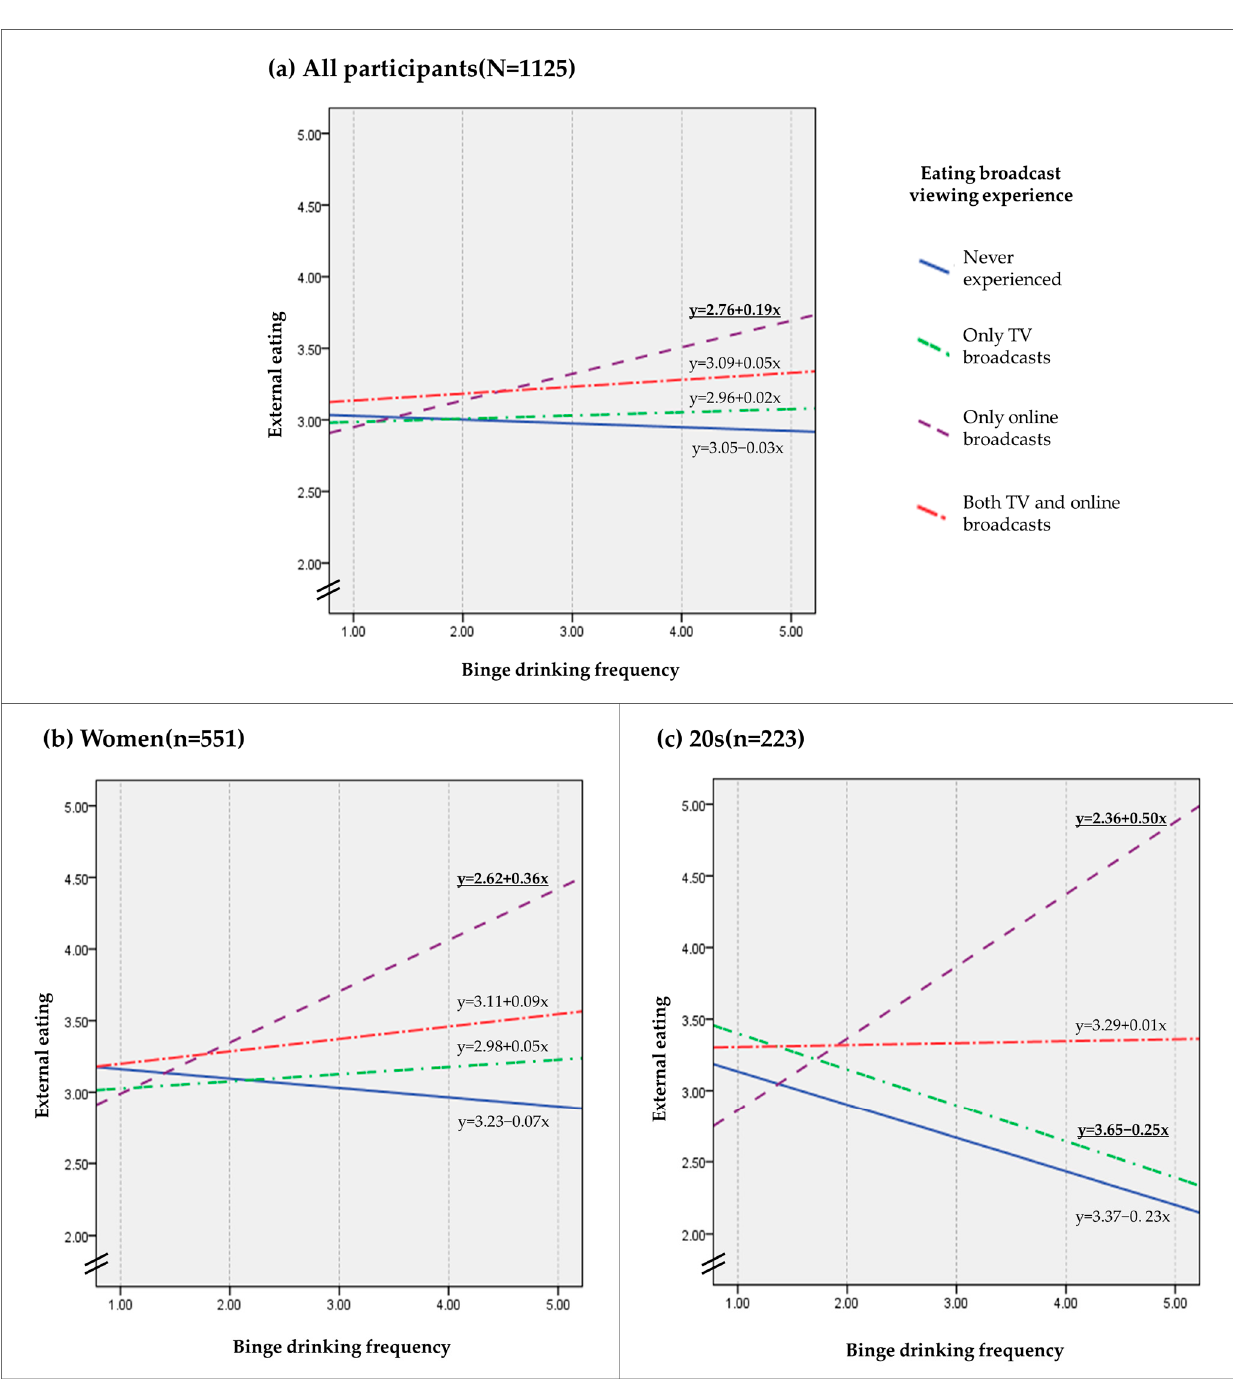
Figure 2. Conditional effects of binge drinking frequency on external eating behavior in four types of eating broadcast viewing experiences among ( a ) all participants, ( b ) women, and ( c ) individuals in their 20s controlled by sex, age group, marriage, annual household income, residence, BMI, stress level, depression level, and disease history. With a p -value of less than 0.05, the regression functions in bold and underlined were significantly different from